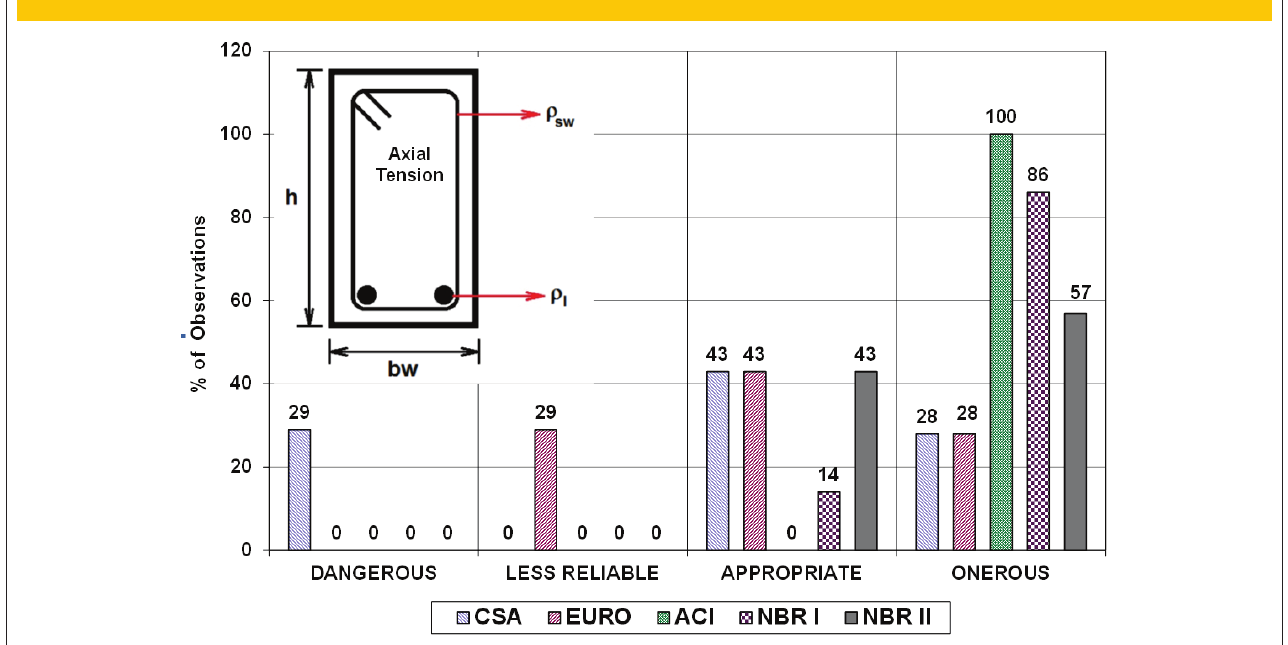
Figure 7 – Reliability analysis for cases under tension, for elements with stirrups